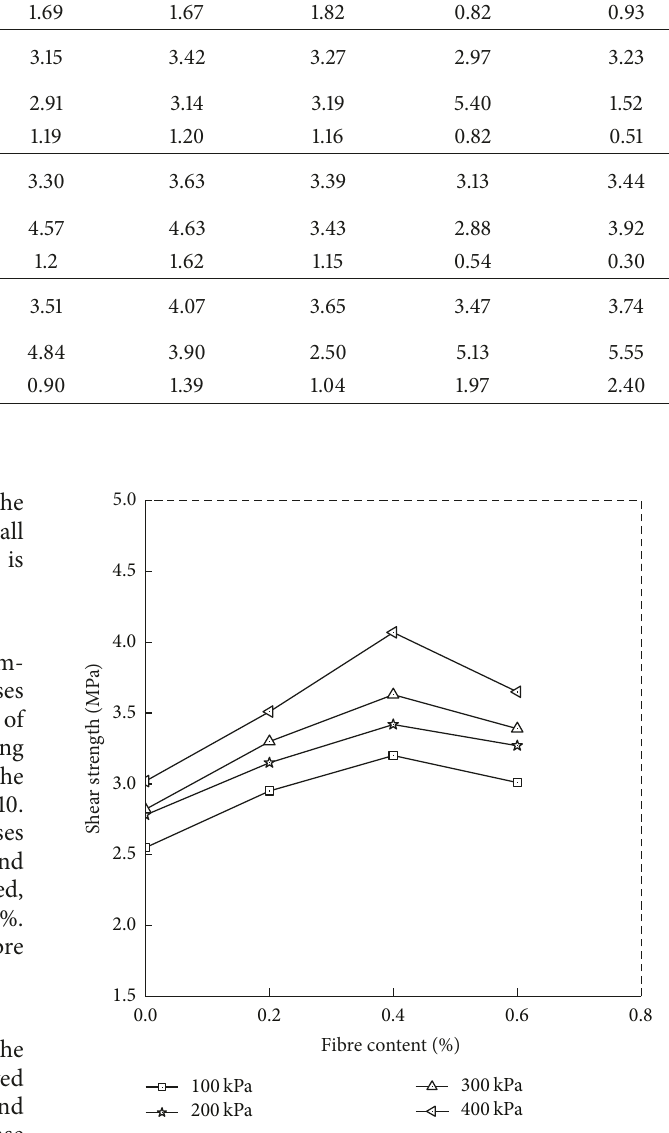
Figure 10: The relationship between fibre content and sample